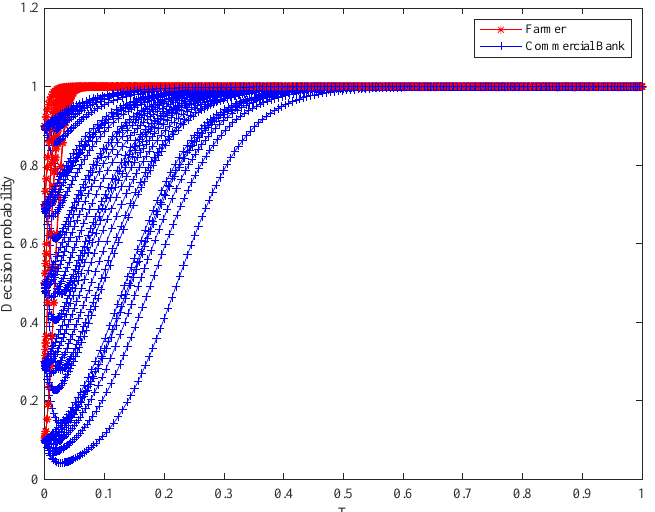
Figure 6. System evolution track after introducing blockchain Technology ( P = 30%).